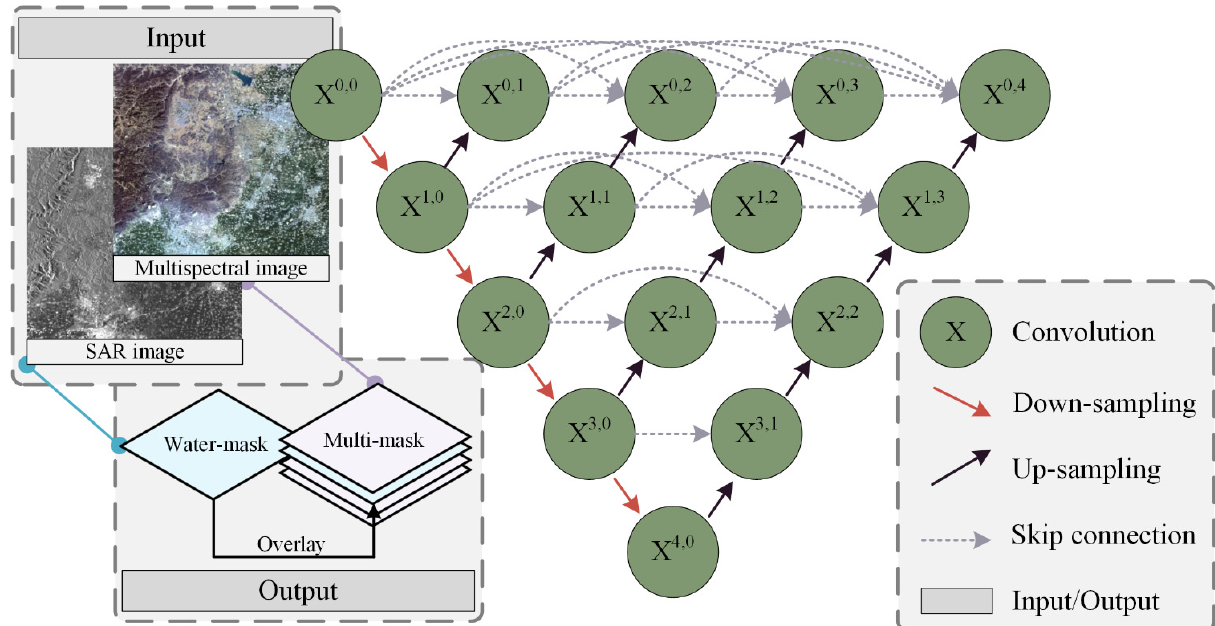
Figure 2. Network structure of flood areal extension extraction and land-use